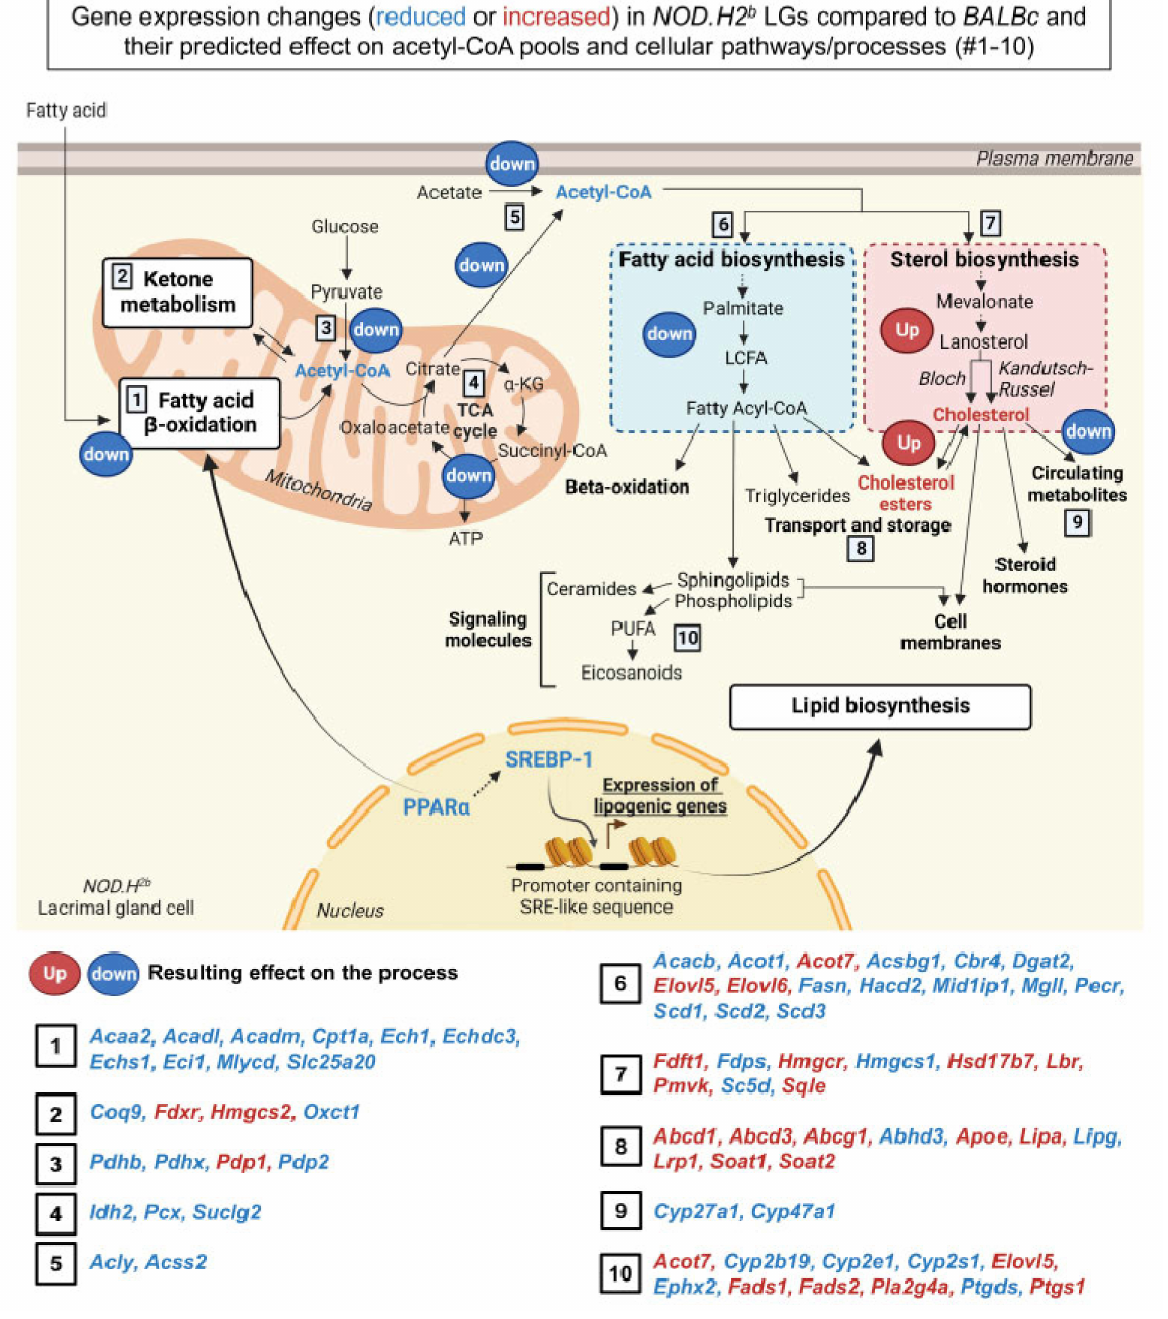
Figure 8. Lipid metabolism is altered in chronically inflamed LGs. According to RNA-seq data of LGs from NOD.H2 b and BALBc mice, disease progression is associated with an overall downregulation (“down”) of PPAR α /SREBP-1 signaling and their downstream target genes involved in fatty acid β -oxidation and TCA (Tricarboxylic acid) cycle happening in the mitochondria, as well as acetyl- CoA/fatty acid biosynthesis that can take place in several cellular compartments. By contrast, genes involved in cholesterol/cholesterol esters biosynthesis are mostly upregulated (“up”) with chronic inflammation. Genes implicated in processes one to ten and significantly altered (upregulated in red, downregulated in blue) during chronic inflammation are shown below. PUFA: Polyunsaturated fatty acid. Created with